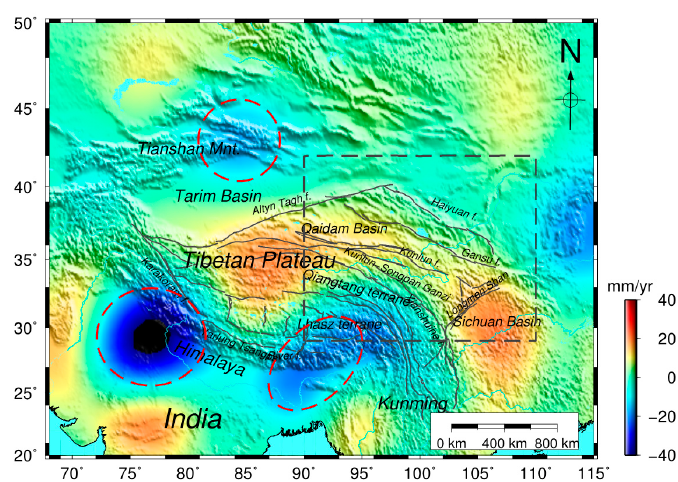
Figure 3. The CSR RL05 GRACE-derived mass change (equivalent water thickness) in Tibet, time spanning from April 2002 to November 2014. The mass change (kg/year) in unit square volume is expressed as equivalent water thickness (mm/year). The inset gray rectangle is our study area, mainly focusing on northeast Tibet. The India, Eastern Himalayas and Tianshan mass changes are shown in the area circled in red.